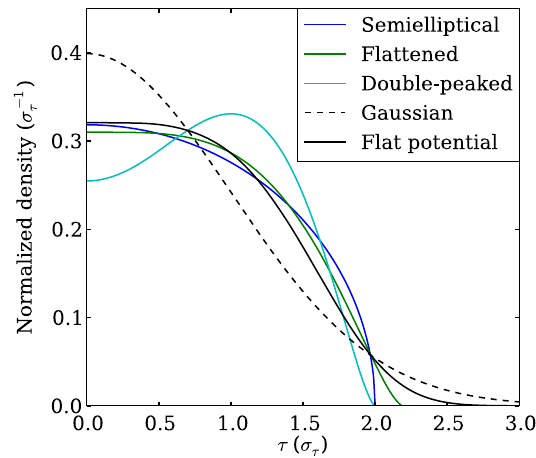
FIG. 1. Bunch profiles for the three non-Gaussian distributions listed in Table II compared to a Gaussian distribution and the distribution expected for the flat potential